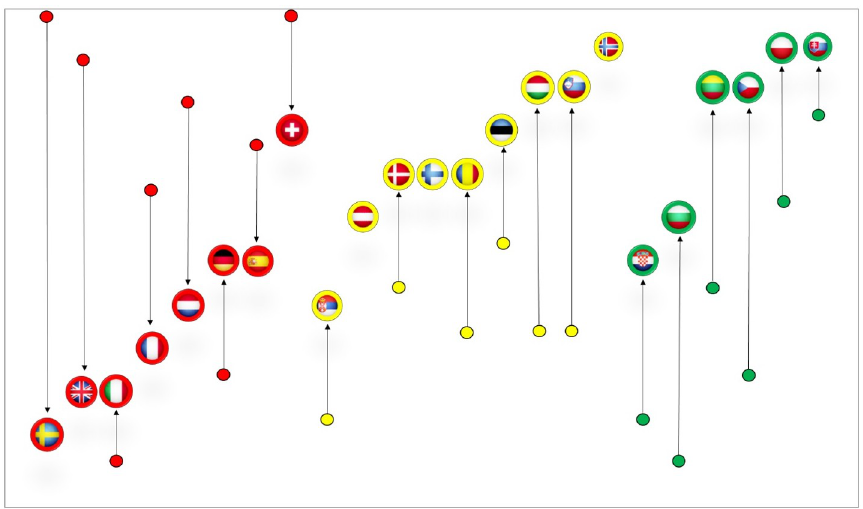
Fig 3. Summary graph—Vertical mobility of countries induced by three reaction